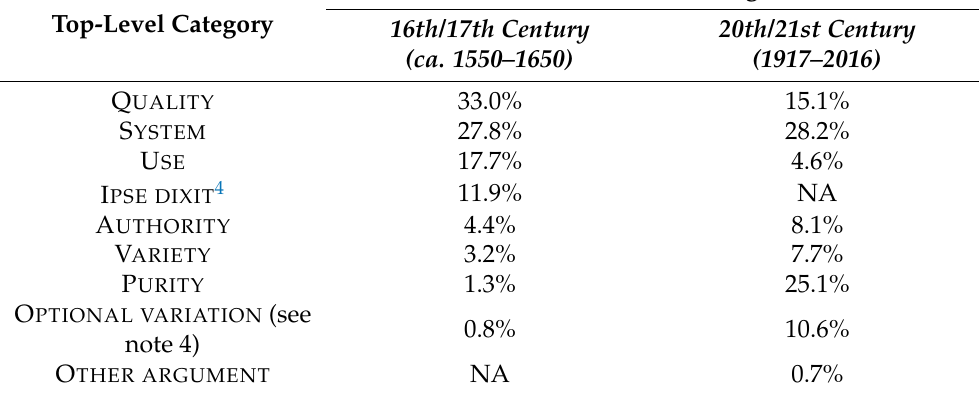
Table 3. Types of arguments used in normative works on Standard Dutch from ca. 1550 to 1650 (total number of arguments: n = 1011) versus 1917–2016 (data taken from Van der Meulen (2020); total number of arguments: n =